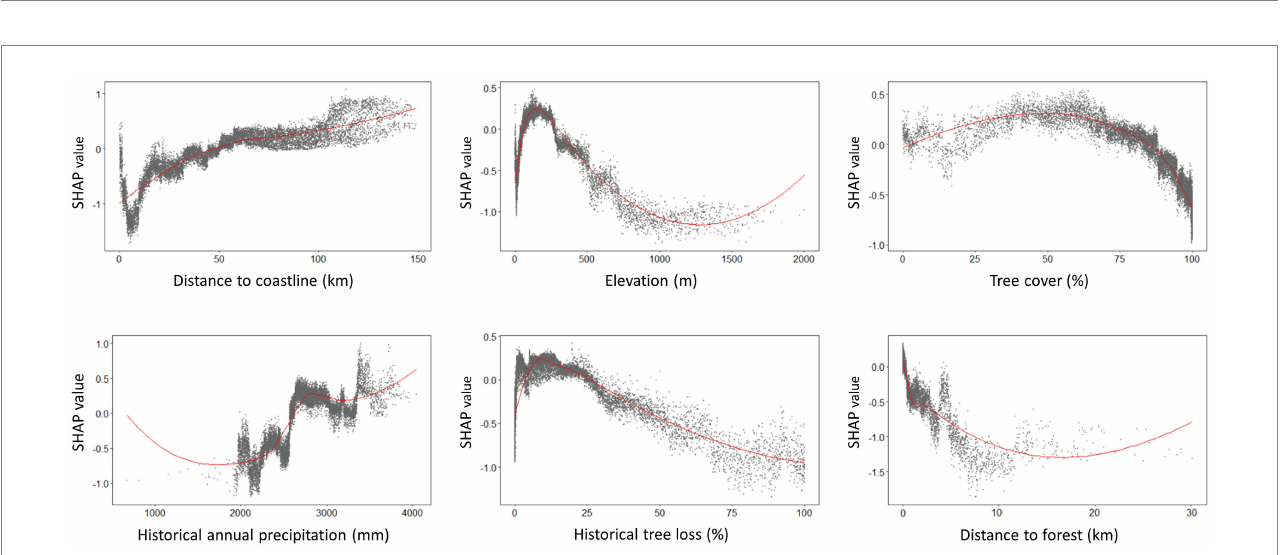
FIGURE 7 SHAP dependence plots generated from XGBoost model demonstrating the environmental suitability range for human knowlesi malaria occurrence based on only key covariates with highest mean absolute SHAP value as reported in Figure 4. Positive SHAP value indicates higher risk of knowlesi malaria infection whereas negative SHAP value indicates lower risk of knowlesi malaria infection. The plots were smoothed using LOESS (locally estimated scatterplot smoothing) curve in